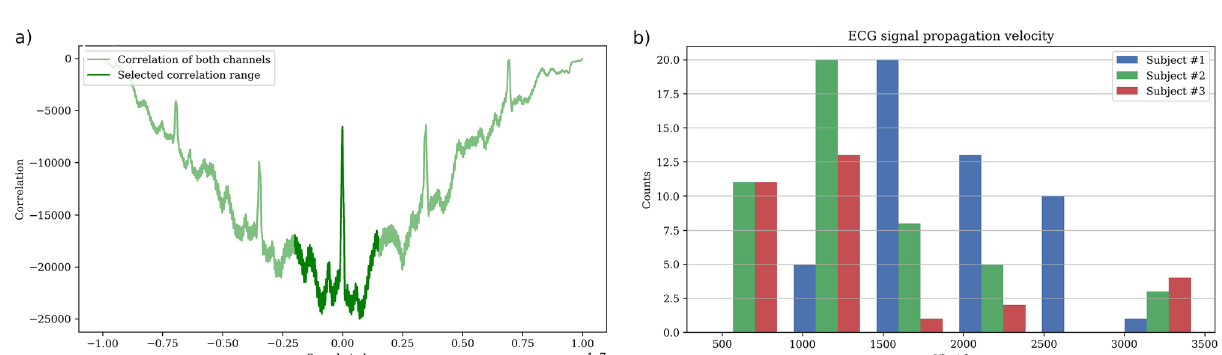
Figure 4. Results of ECG signal propagation velocity